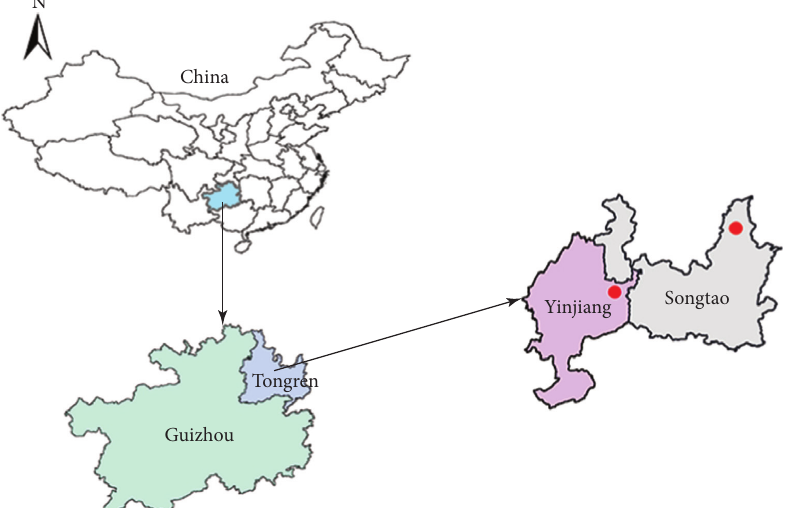
Figure 1: Sampling collected sites: Yinjiang means the sites of mine waste slag areas and Songtao means the sites of electrolytic manganese slag